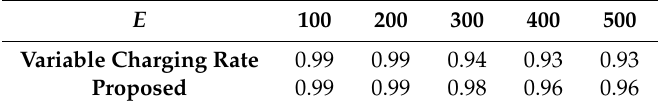
Table 5. Average State-of-Charge (SoC) of the EV’s Battery at departure time.